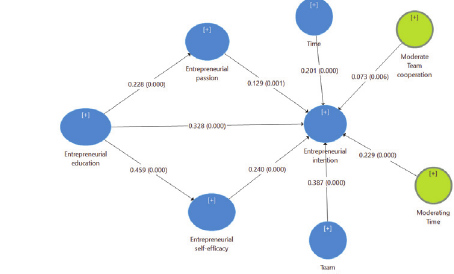
Fig. 5. The bootstrap result with 2 moderator variables